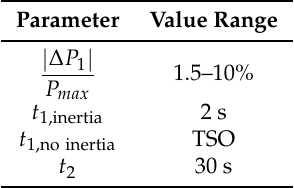
Table 1. Active power frequency response parameters. TSO: Transmission System